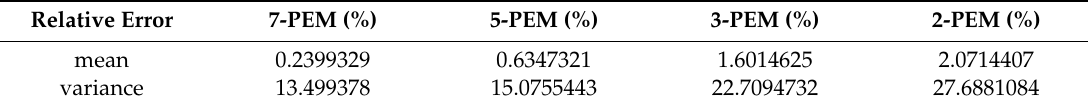
Figure 8. Case 2 results. ( a ) Mean pressure for the natural gas network. ( b ) Variance in pressure for the natural gas network. ( c ) Mean pressure for the power network. ( d ) Variance in pressure for the power network. Table 4. Average relative error of the gas network.